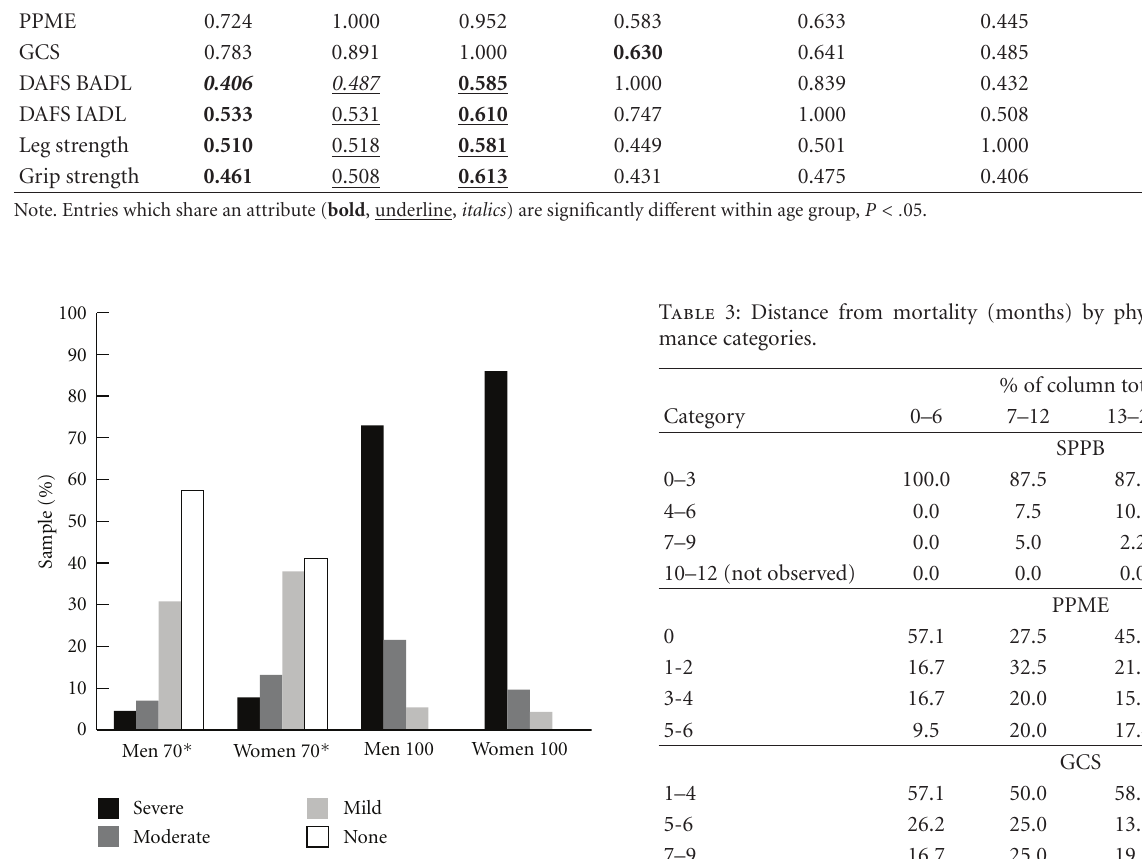
Figure 1: Comparison of SPPB performance categories between GCS Centenarians and EPESE 70–79 Cohort.